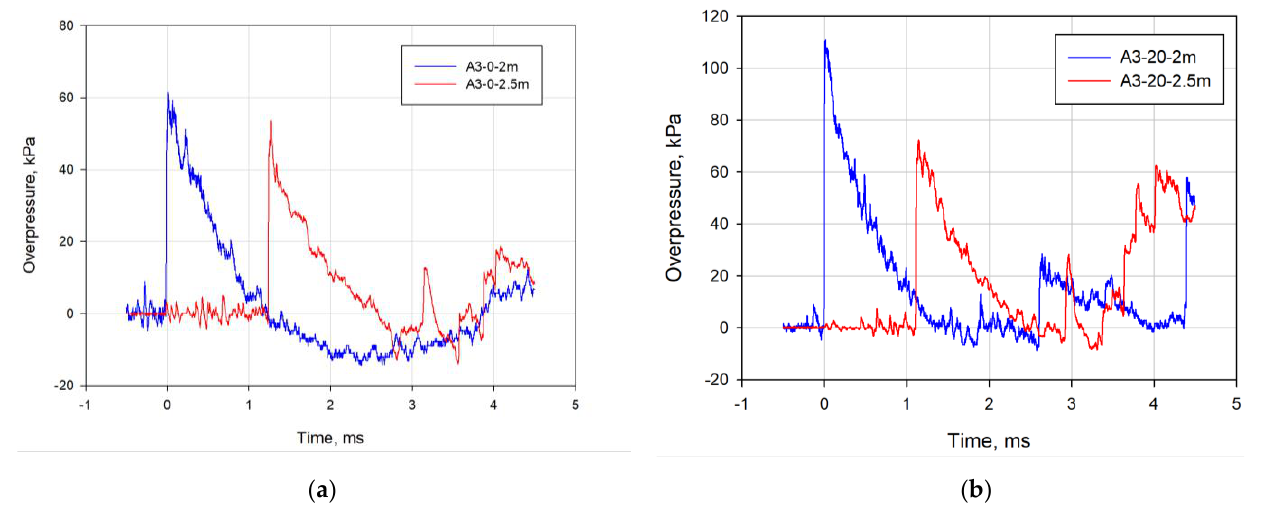
Figure 4. Blast waves overpressure for compositions ( a ) A3-0 and ( b ) A3-20. The obtained overpressure histories were approximated using a modified Friedlander equation. The obtained maximum overpressure and positive phase impulse values were averaged. Measurements were performed for all the tested materials. Tables 2 and 3 present the determined characteristics of the air blast wave. Table 2. Results of the measurements of blast wave characteristics for ammonals with 3% Al f .